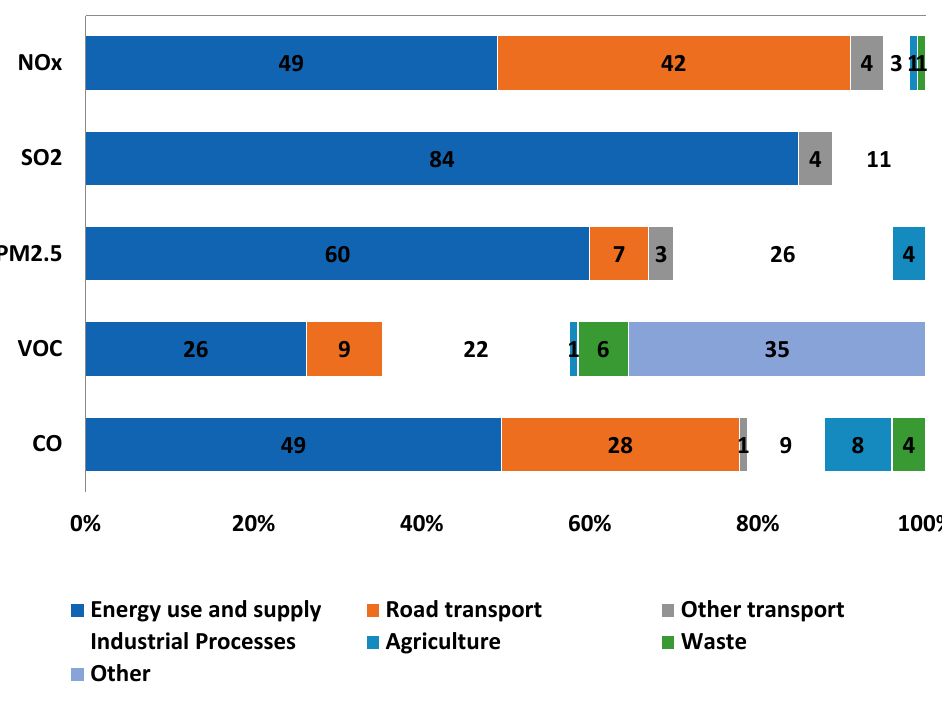
Figure 3. Greenhouse gas emissions.